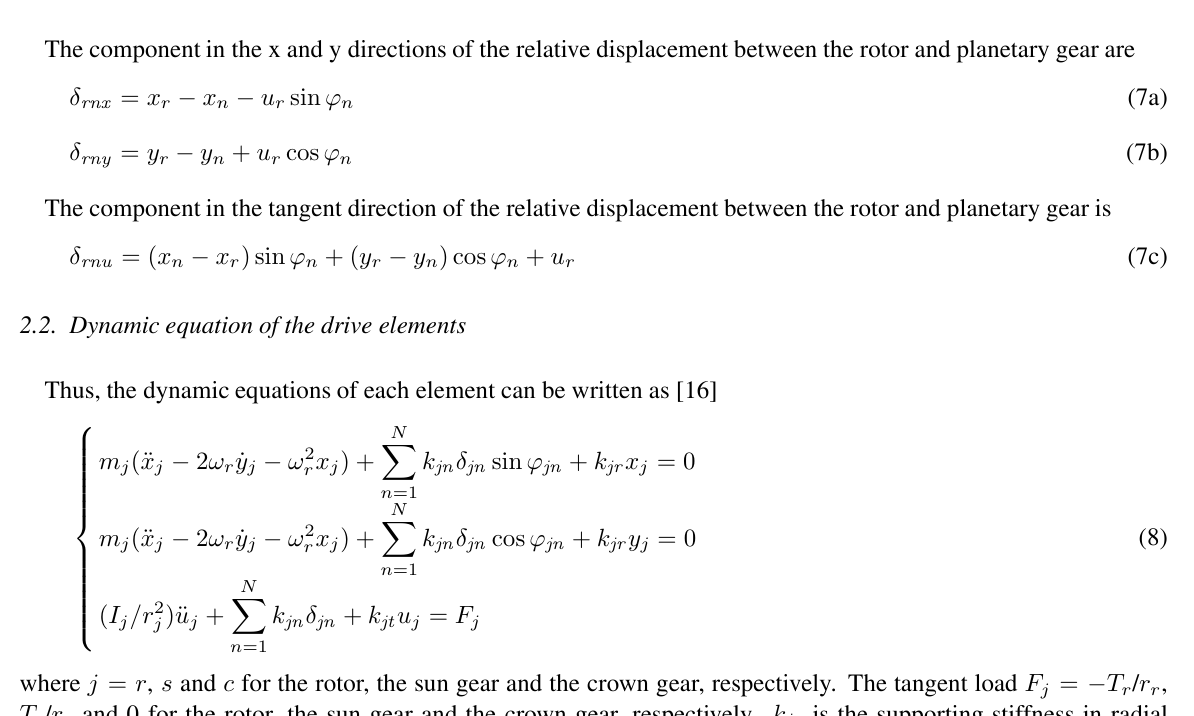
Fig. 3. Relative displacements of the